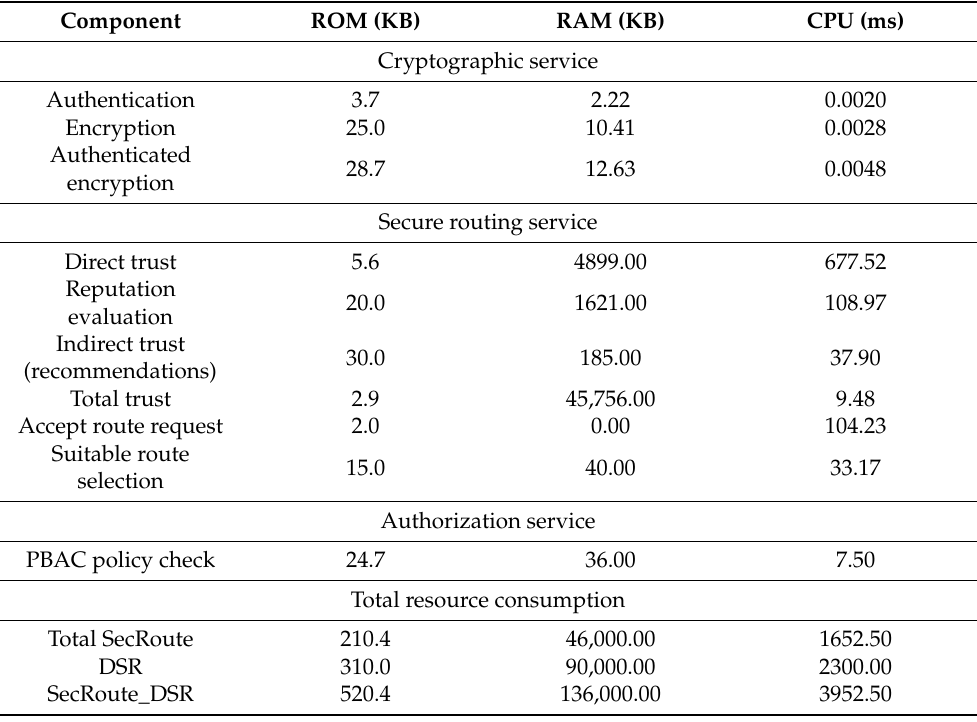
Table 3. Resource allocation for SecRoute on BeagleBone